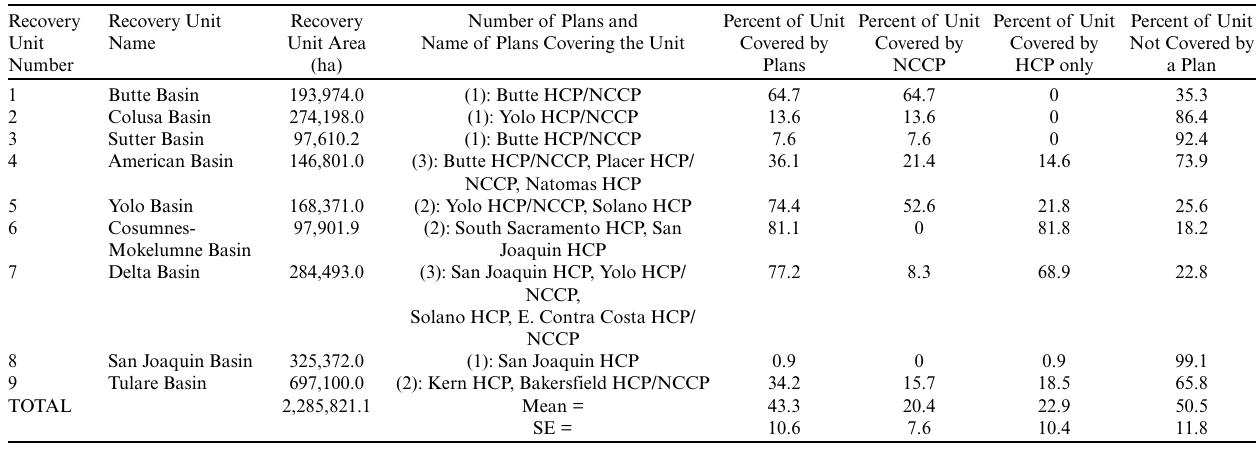
Table 2 . Recovery units for the giant garter snake ( Thamnophis gigas ) with the habitat conservation plans (HCPs) and natural community conservation plans (NCCPs) that cover each unit. The recovery unit number corresponds with Figure